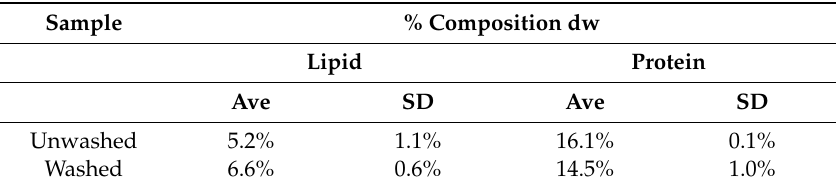
Table 3. Lipid and protein contents of S. muticum before and after freshwater washing.